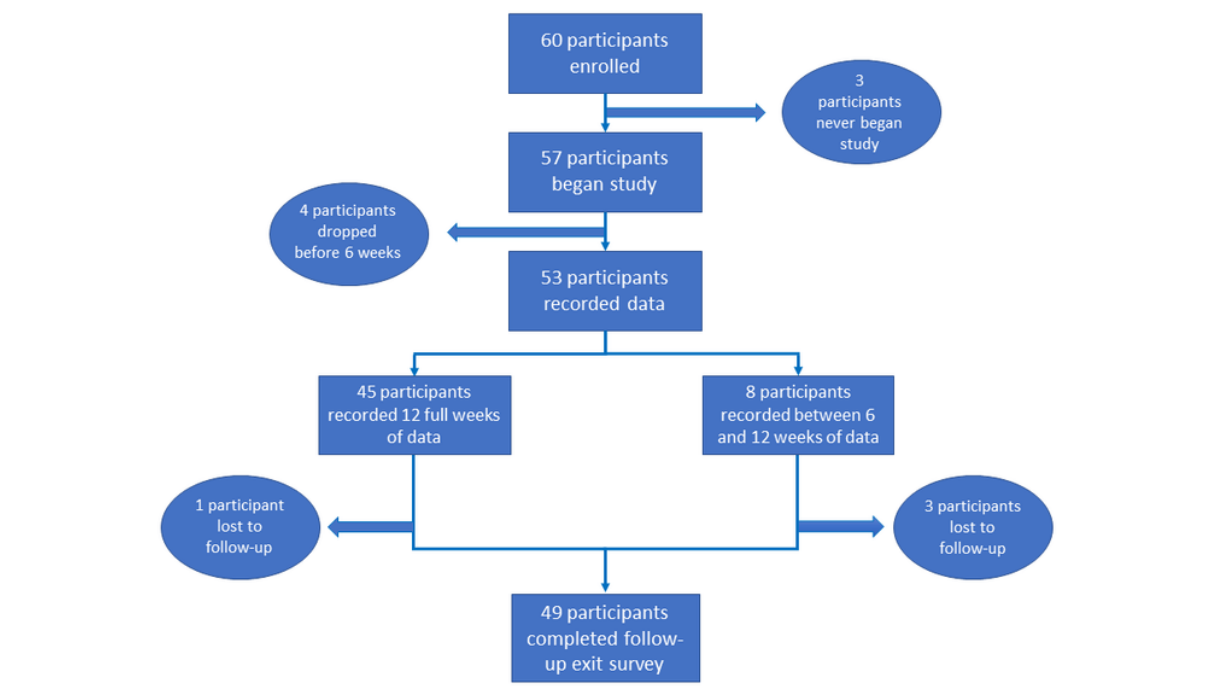
Figure 1. Participant